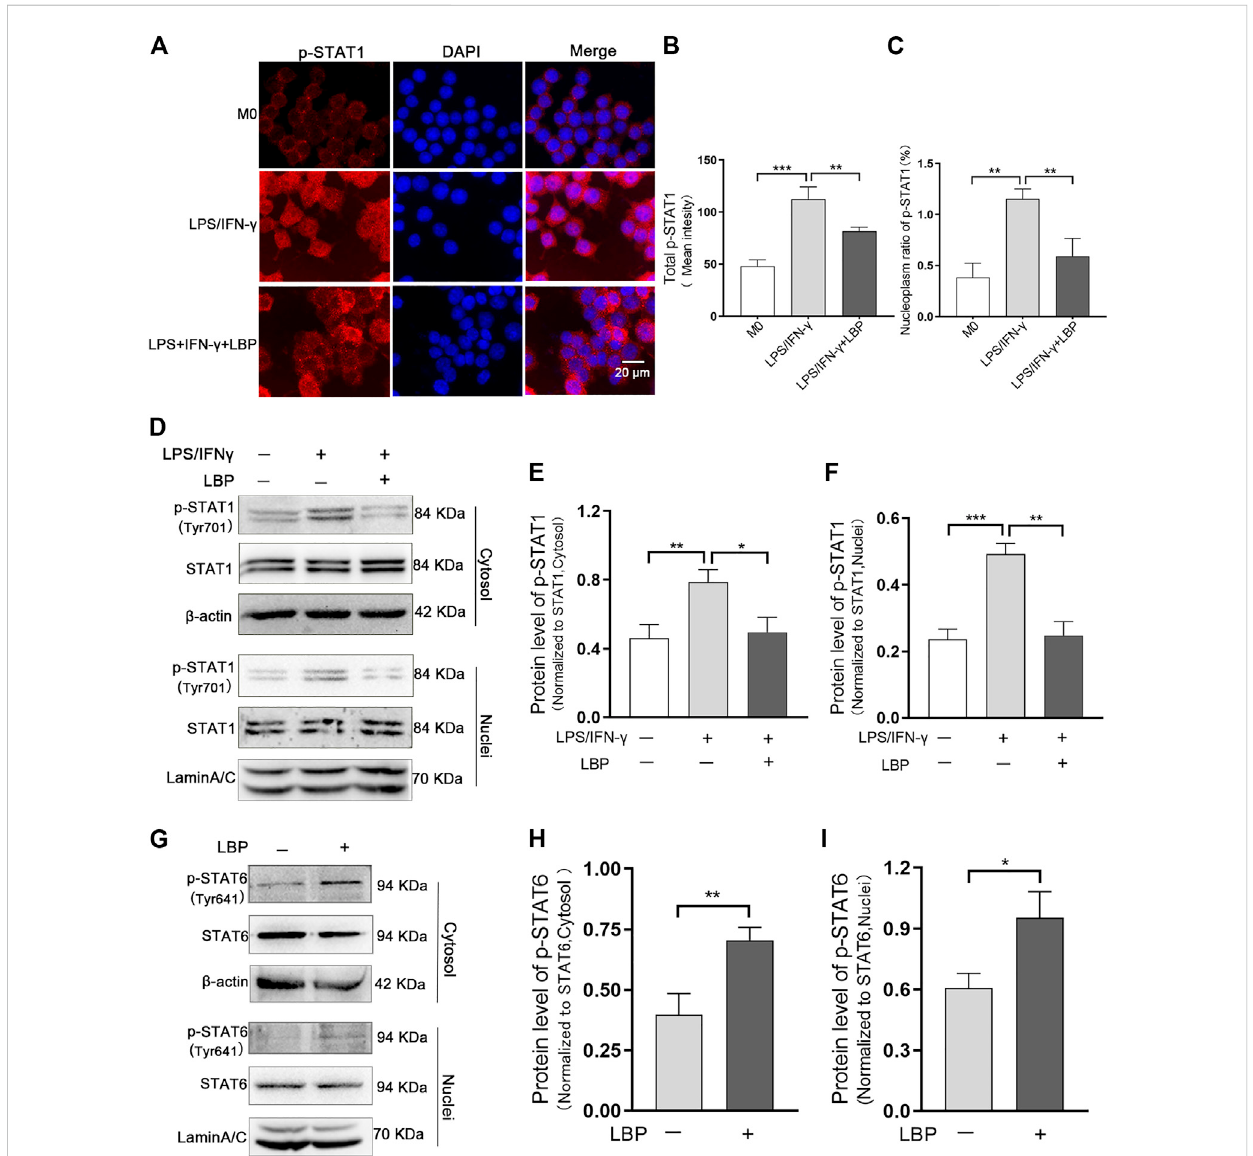
(C) The quanti fi cation result of mean fl uorescence density nucleoplasm ratio of p-STAT1in Figure 6A. (D) Western blot results of p-STAT1 in the cytosol and nuclei of RAW264.7 cells after stimulation with LPS/IFN- γ , with or without LBP treatment. (E) The quanti fi cation of the Western blot bands of p-STAT1 in the cytosol in Figure 6D. (F) The quanti fi cation of the Western blot bands of p-STAT1 in the nuclei in Figure 6D. (G) Western blot results of p-STAT6inthecytosolandnucleiofLBP-treatedanduntreatedRAW264.7cells. (H) Thequanti fi cationofWesternblotbandsofp-STAT6inthecytosolin Figure 6G. (I) The quanti fi cation ofWesternblot bandsof p-STAT6 inthe nuclei in Figure 6G. Signi fi cant differences are indicated as * p < 0.05, ** p < 0.01, *** p <